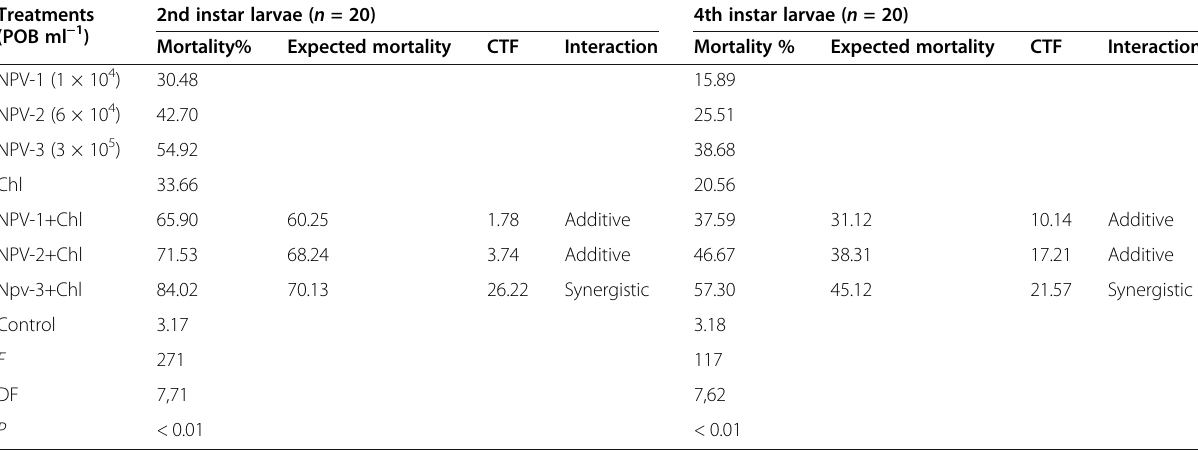
Table 2 Mortality percentage of the 2nd and 4th instars of Spodoptera exigua larvae treated with nucleopolyhedrovirus alone and in combination with chlorantraniliprole Treatments (POB ml − 1 )